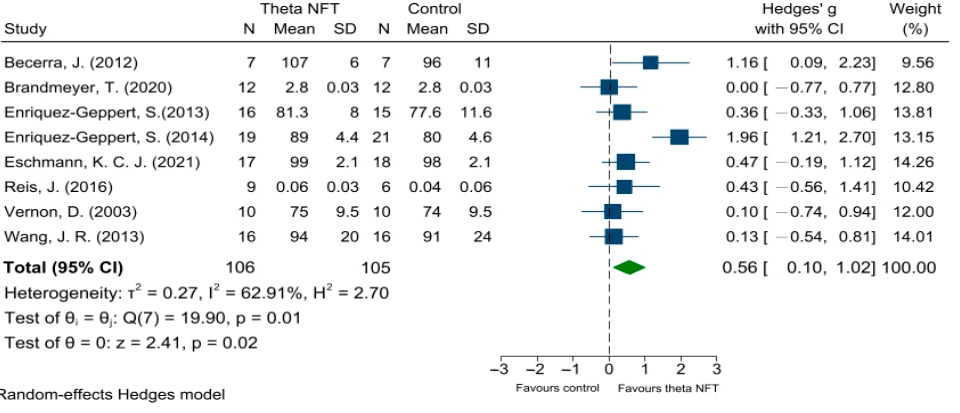
Figure 3. Forest plots showing meta-analysis of effect of NFT of theta activity on WM in healthy participants. CI = confidence interval; SD = standard deviation [14,18,19,24,25,33–35].